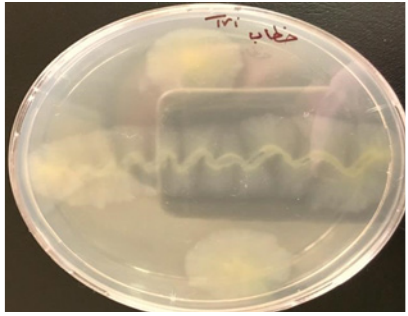
Fig. 7. Lipase test for Staph.aureus isolated